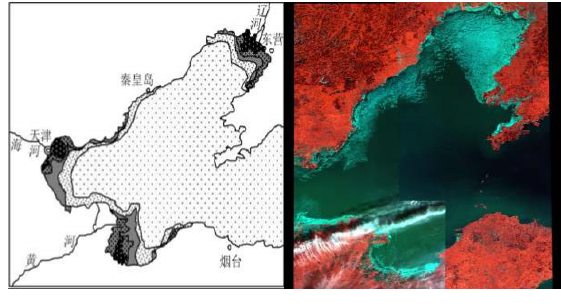
Figure 1. The study area of Bohai Sea